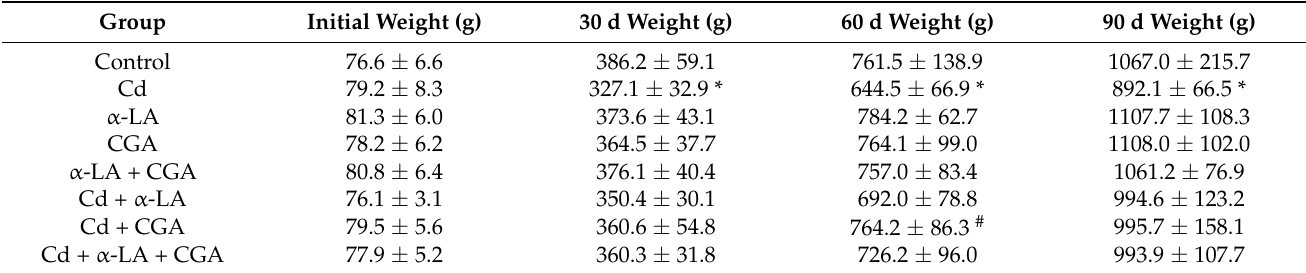
Table 2. The body weight of experimental chickens in each group at the day of 0, 30, 60 and 90.